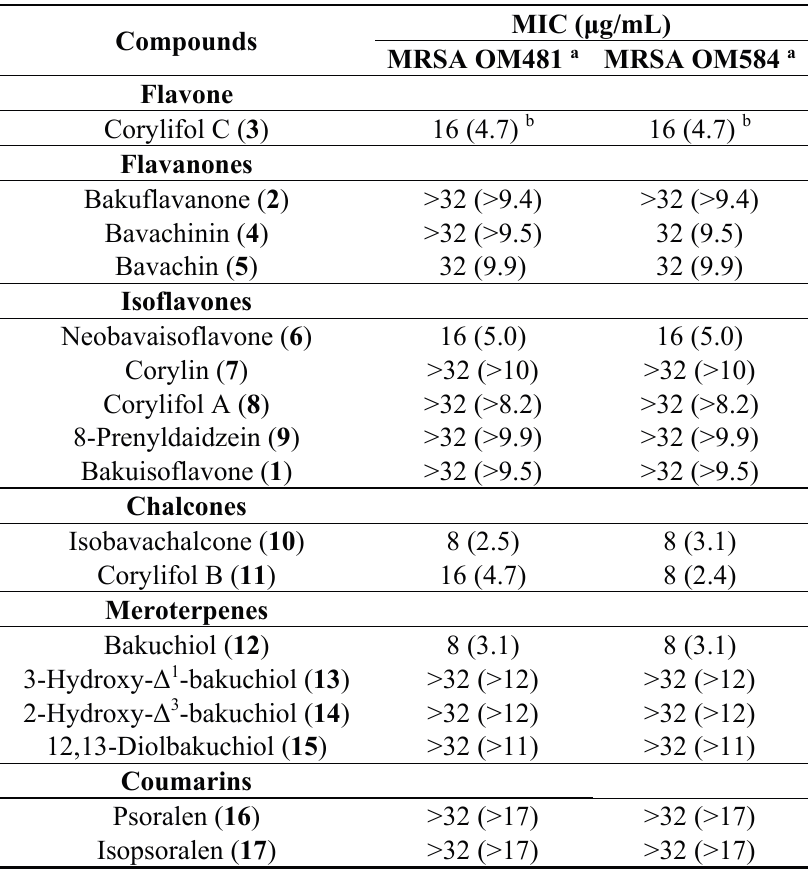
Table 2. Antibacterial effects of compounds 1 – 17 against MRSA